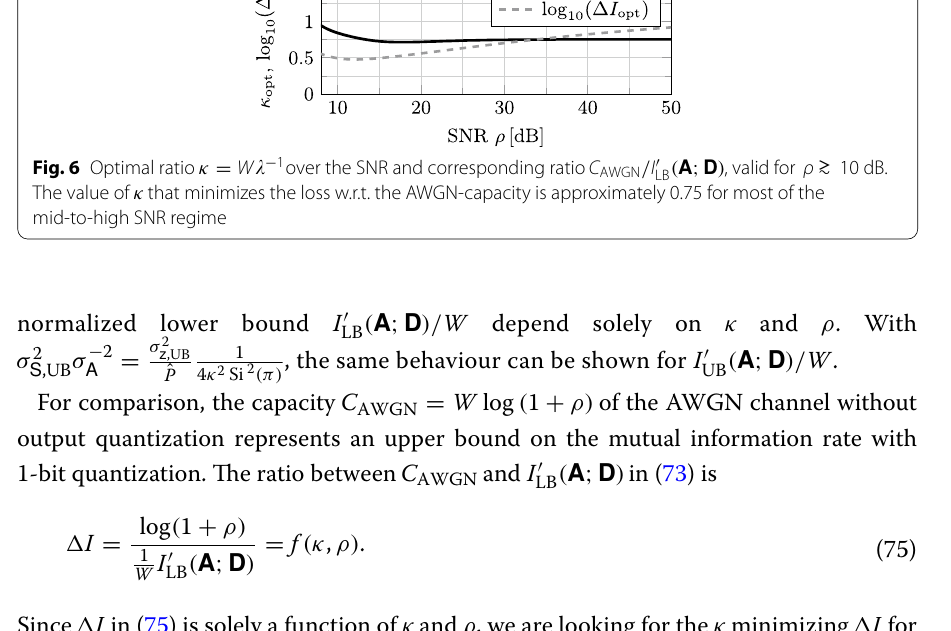
D ) , valid for ρ ≳ 10 dB. ( A LB ;